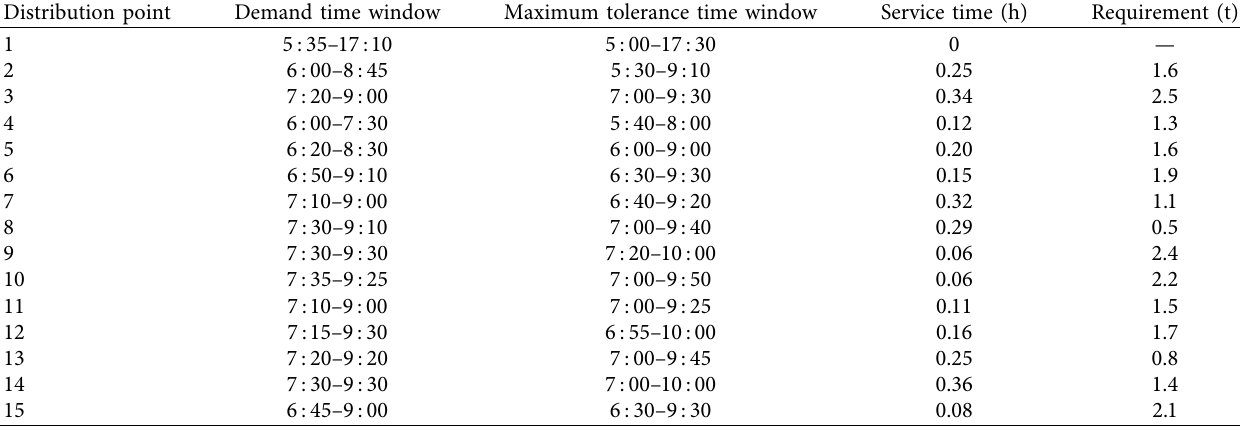
Table 3: Time window, maximum tolerance time window and service time of demand points.